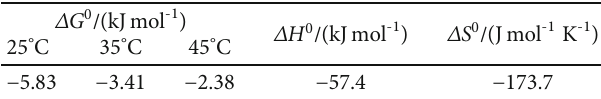
Table 6: Thermodynamic data on elimination of bisphenol A onto AgNPs-SB- β